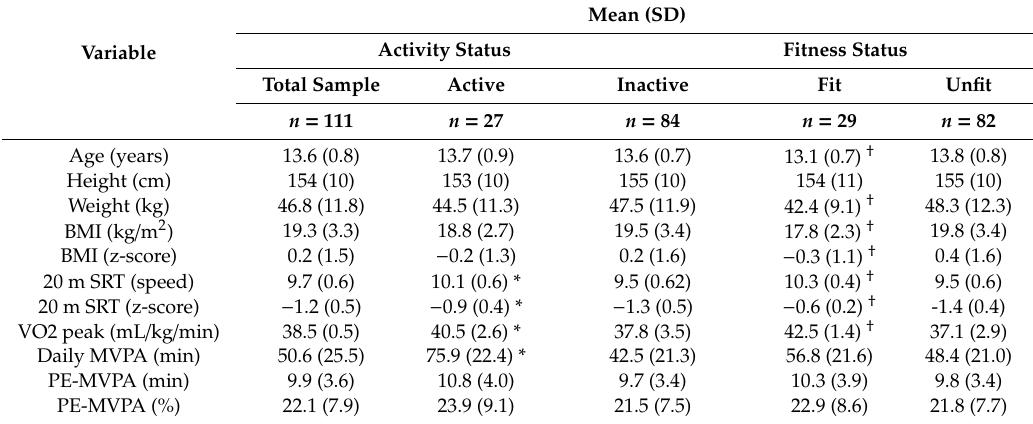
Table 1. Descriptive statistics for the study variables across groups that di ff ered in their levels of physical activity and fitness.